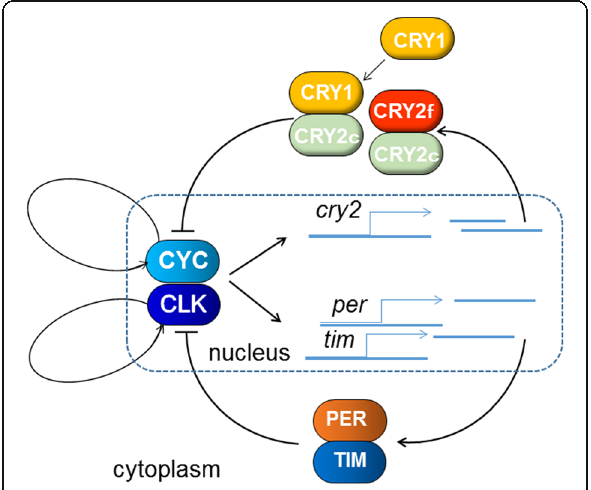
Fig. 8 A model for the cricket circadian clock. The clock includes two negative feedback loops, one for Gb ’ per / Gb ’ tim like in Drosophila and the other for Gb ’ cry2 . The latter is comprised of two Gb ’ cry2 variants, Gb ’ cry2 c and Gb ’ cry2 f, or Gb ’ cry2 c and Gb ’ cry1 , and their product proteins that form a complex to suppress the transcription mediated by Gb ’ CLK/ Gb ’ CYC complex. These two loops may be able to operate independently but interact with each other through influence on the Gb ’ CLK/ Gb ’ CYC. In addition, there are two other loops for rhythmic expression of Gb ’ Clk and Gb ’ cyc